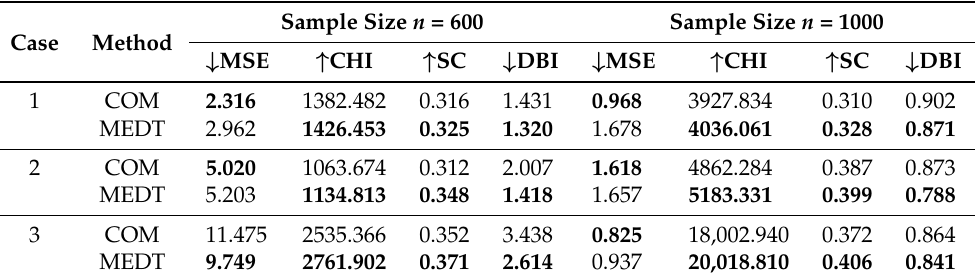
Table 2. Comparative performance under two different settings. The best result is in boldface. The up or down arrow indicates the higher or lower metric corresponds to the better one.